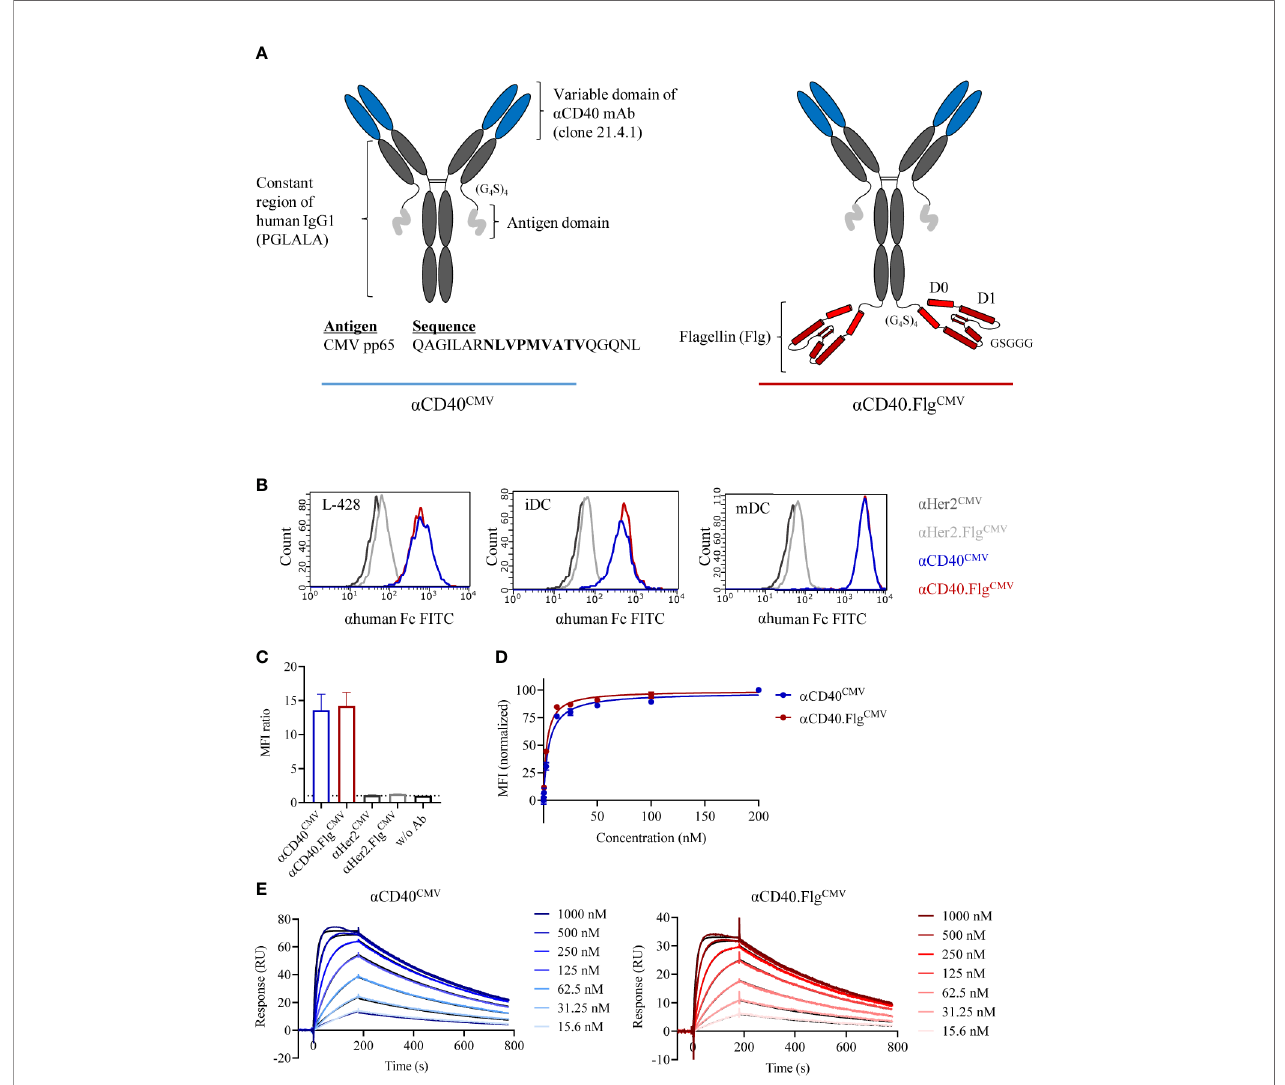
FIGURE 1 | Modular composition and binding characteristics of a CD40 CMV and a CD40.Flg CMV . (A) Schematic drawing of a CD40 CMV (left) and a CD40.Flg CMV (right). The CMV epitope sequence is shown in bold. PGLALA are amino acid mutations introduced for Fc silencing. (B) Histograms of a CD40 CMV and a CD40.Flg CMV compared to the non-speci fi c binding controls a Her2 CMV and a Her2.Flg CMV at saturating concentrations analyzed by fl ow cytometry. Binding to L-428 cells, immature (iDCs), and mature (mDCs) monocyte-derived DCs (moDCs) was assessed. Histograms from one of three experiments are shown and are typical of the data. (C) Maximum binding of a CD40 CMV, a CD40.Flg CMV and the respective Her2 controls to iDCs from different donors, as measured by fl ow cytometry ( n = 4). (D) Binding curves of a CD40 CMV and a CD40.Flg CMV in L-428 cells as determined by fl ow cytometry ( n = 3). (E) Representative SPR pro fi les for a CD40 CMV and a CD40.Flg CMV . An a human Fc antibody was coated onto a CM5 chip to immobilize a CD40 IgG1 antibodies. The extracellular domain of CD40 (the analyte) was injected and the concentration-dependent on- and off-rates were determined. Colored curves represent raw data and black curves fi tted data. Data represent mean ±